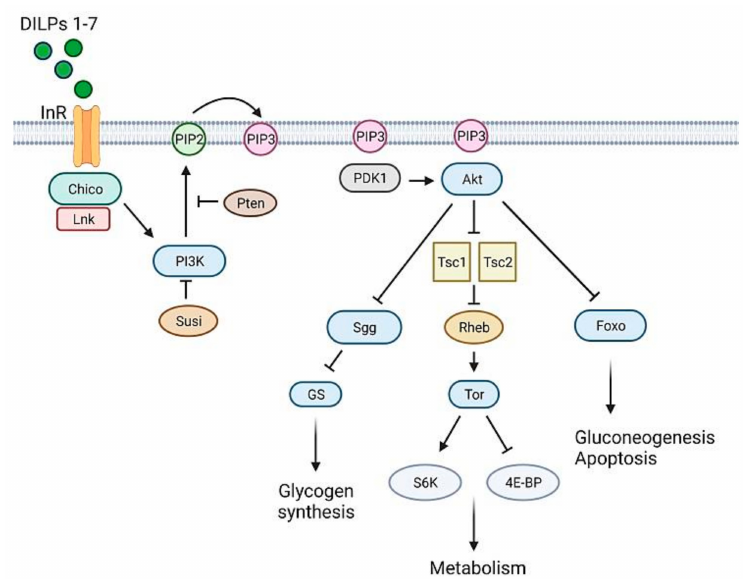
Figure 4. The Drosophila insulin signaling pathway, a simplified schematic representation. The Drosophila insulin-like peptides (DILP1-7) bind to insulin-like receptor (InR), which recruits the docking proteins Chico and Lnk. These proteins activate PI3K which converts PIP2 to PIP3 in the plasma membrane. The production of PIP3 is negatively regulated by PTEN and Susi. PIP3 recruits two kinases, PDK1 and Akt, to the plasma membrane enabling PDK1 to phosphorylate Akt. Akt mediates several signaling pathways essential for cell growth and survival, by acting on several downstream substrates, such as the transcription factor Foxo involved in metabolism and stress responses, the Tsc1/Tsc2 complex, an inhibitor of the Tor signaling pathway and essential regulator of growth and metabolism, and Sgg whose inactivation promotes the activity of glycogen synthase (GS). Figure 4 was created with BioRender.com (https://app.biorender.com, accessed on 15 September